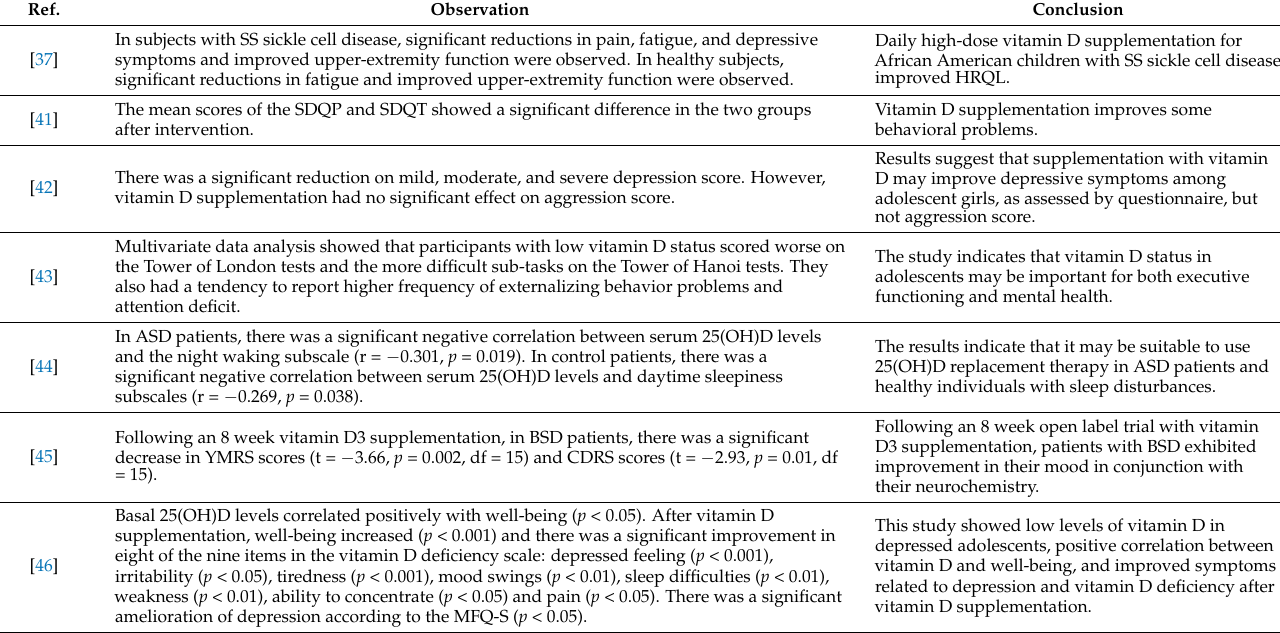
Table 5. The findings presented in the intervention studies included to the systematic review.